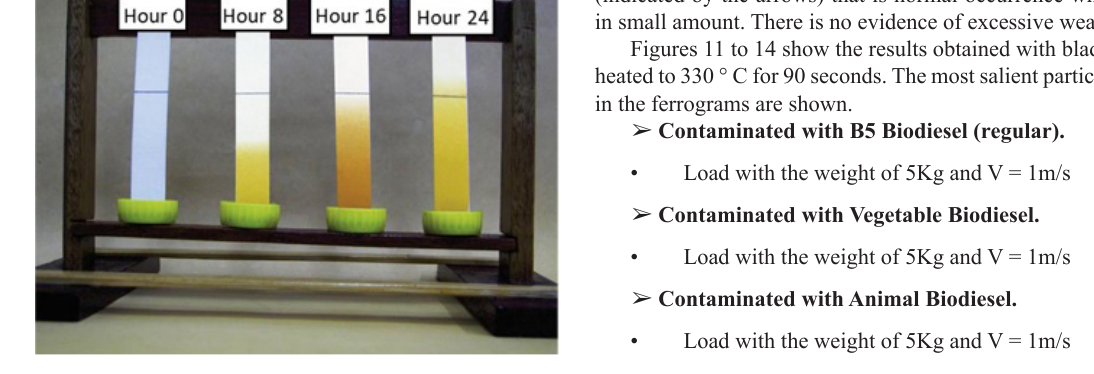
Figure 6. Dispersion test for all contamination.